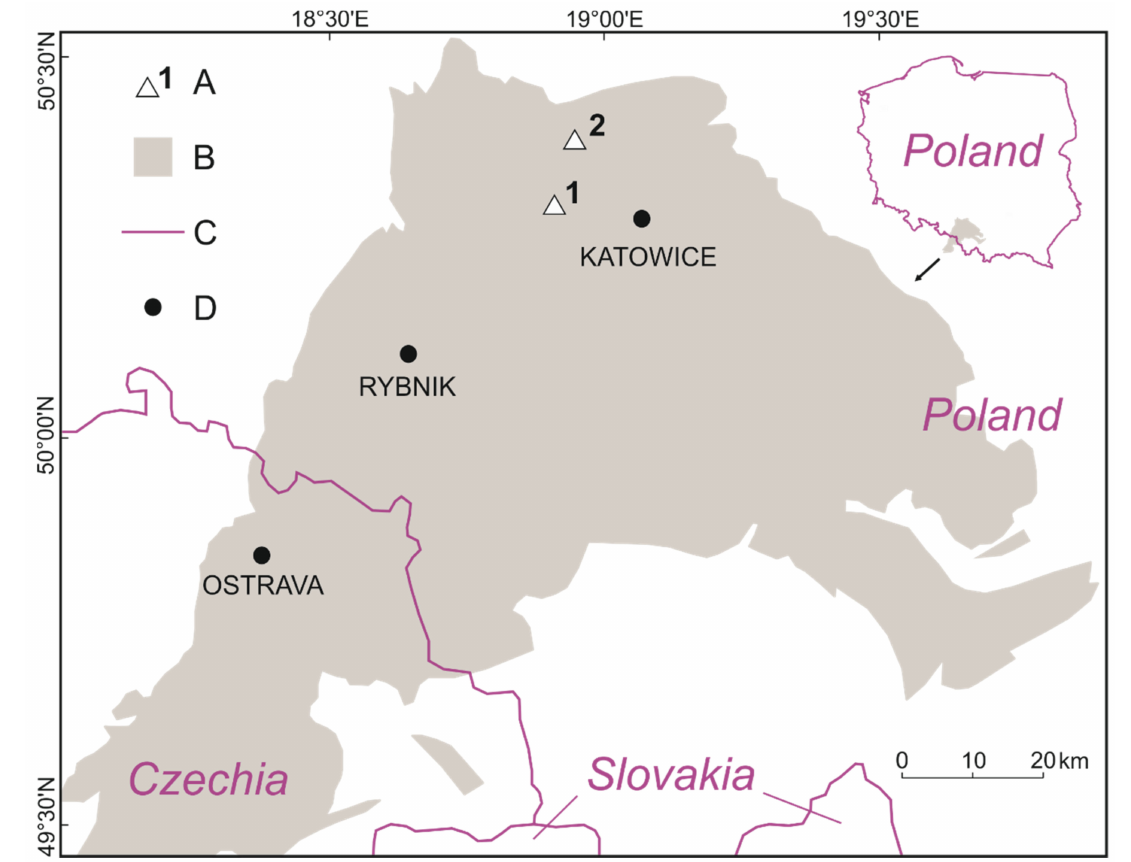
Figure 1. Location of the study area, where A: the investigated dumps (1: D-RS-1 and 2: D-B-2), B: the Upper Silesian Coal Basin (USCB) range, C: the state borders, and D: the main